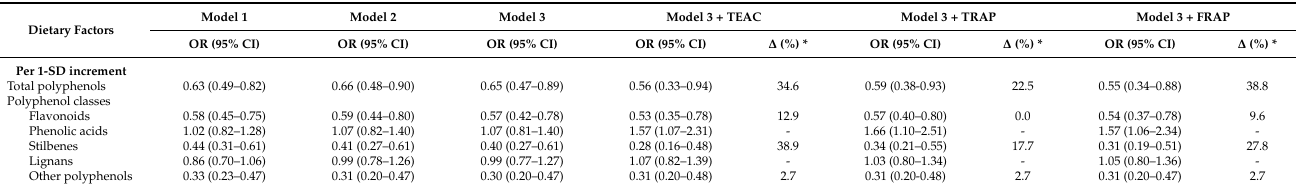
Table 4. Association of dietary polyphenols with risk of Lumbar Spinal Stenosis.